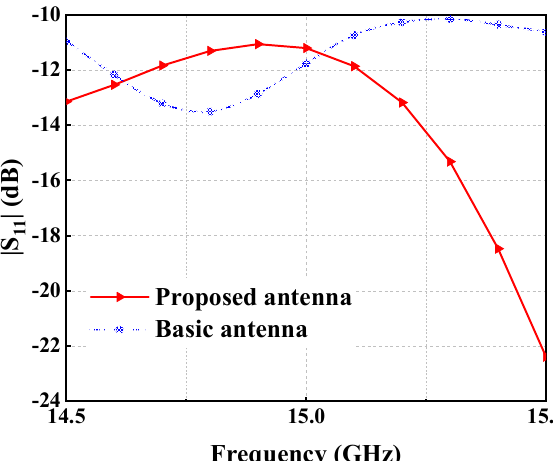
Figure 2. Simulated reflection coefficients of the proposed wide − beam antenna and basic ALTSA.